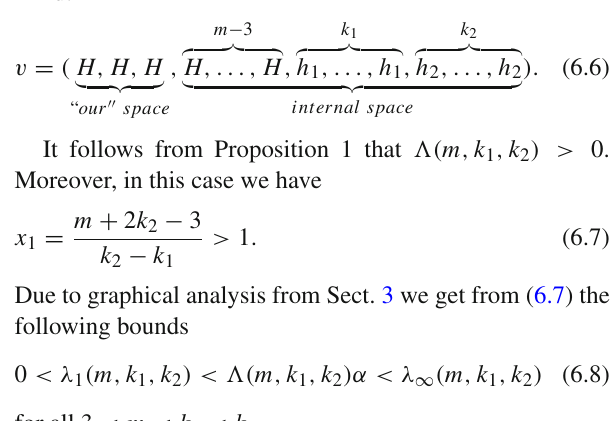
In the 3 d space of Hubble-like parameters H , h 1 , h 2 , relation (7.1) describes a plane while (7.2) corresponds to an ellipsoid. The intersection of this plane and ellip- soid gives us an ellipse E . For m = 3, k 1 = 4, k 2 = 5 and α = 1 this intersection is depicted at Fig. 6. For H (cid:2)= 0 and m < k 1 < k 2 the solu- tions for ( H , h 1 , h 2 ) are described by 1-dimensional mani- fold E sol = E \{ N , S , Y 1 , Y 2 , Y 3 , Y 4 , − Y 1 , − Y 2 , − Y 3 , − Y 4 } , wherepoints N , S correspondto H = 0,points Y 1 , Y 2 , Y 3 , Y 4 correspond to H > 0 and relations h 1 / H = X 1 , h 2 / H =